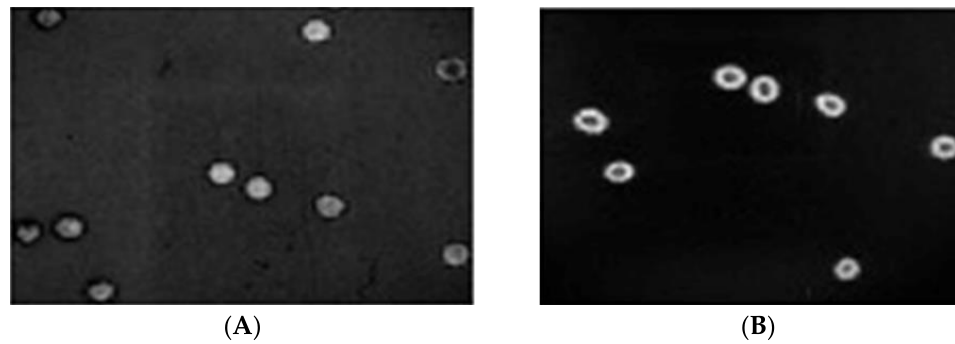
Figure 1. Under the fluorescent microscope (40×), the subcellular localization of Photofrin ® revealed satisfactory uptake throughout the cytoplasm of CAM RBCs at 10 s and 20 s ( A , B ).